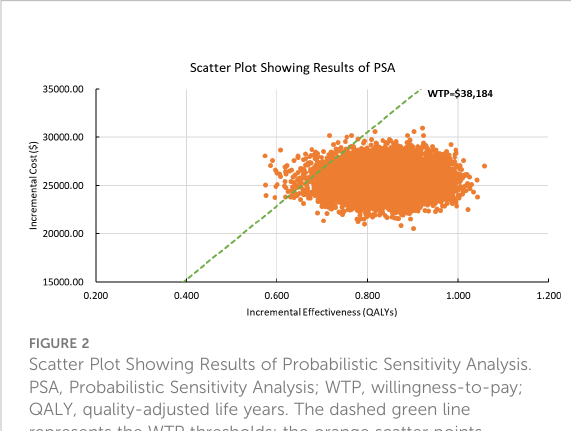
FIGURE 2 Scatter Plot Showing Results of Probabilistic Sensitivity Analysis. PSA, Probabilistic Sensitivity Analysis; WTP, willingness-to-pay; QALY, quality-adjusted life years. The dashed green line represents the WTP thresholds; the orange scatter points represent the simulated ICER points.